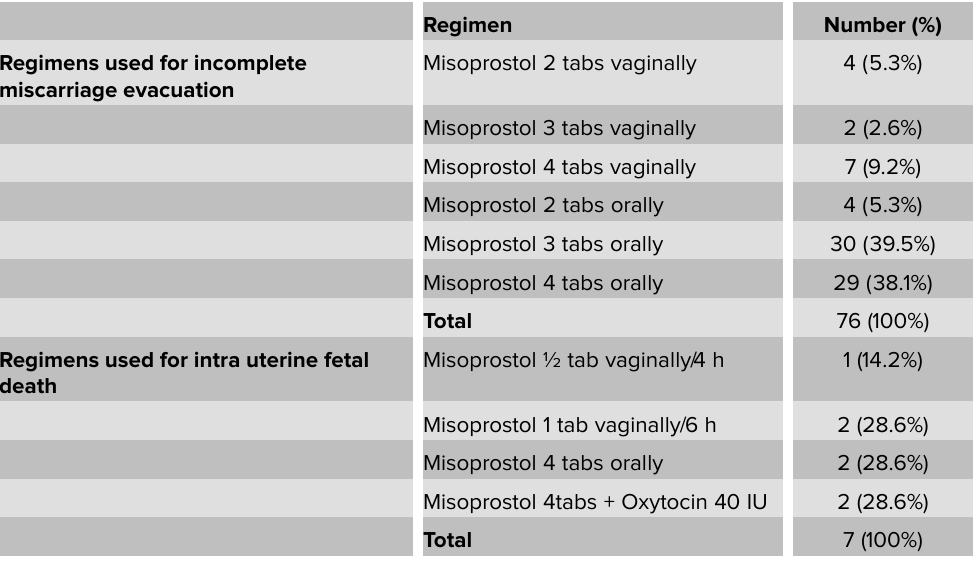
TABLE 5: Different regimens used for incomplete miscarriage evacuation and intra uterine fetal